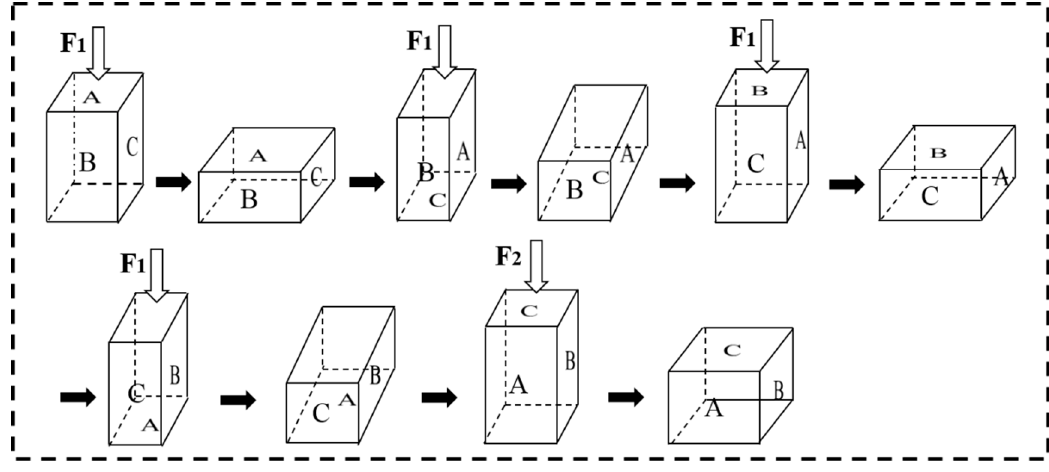
Figure 2. Schematic of the multidirectional forging process.